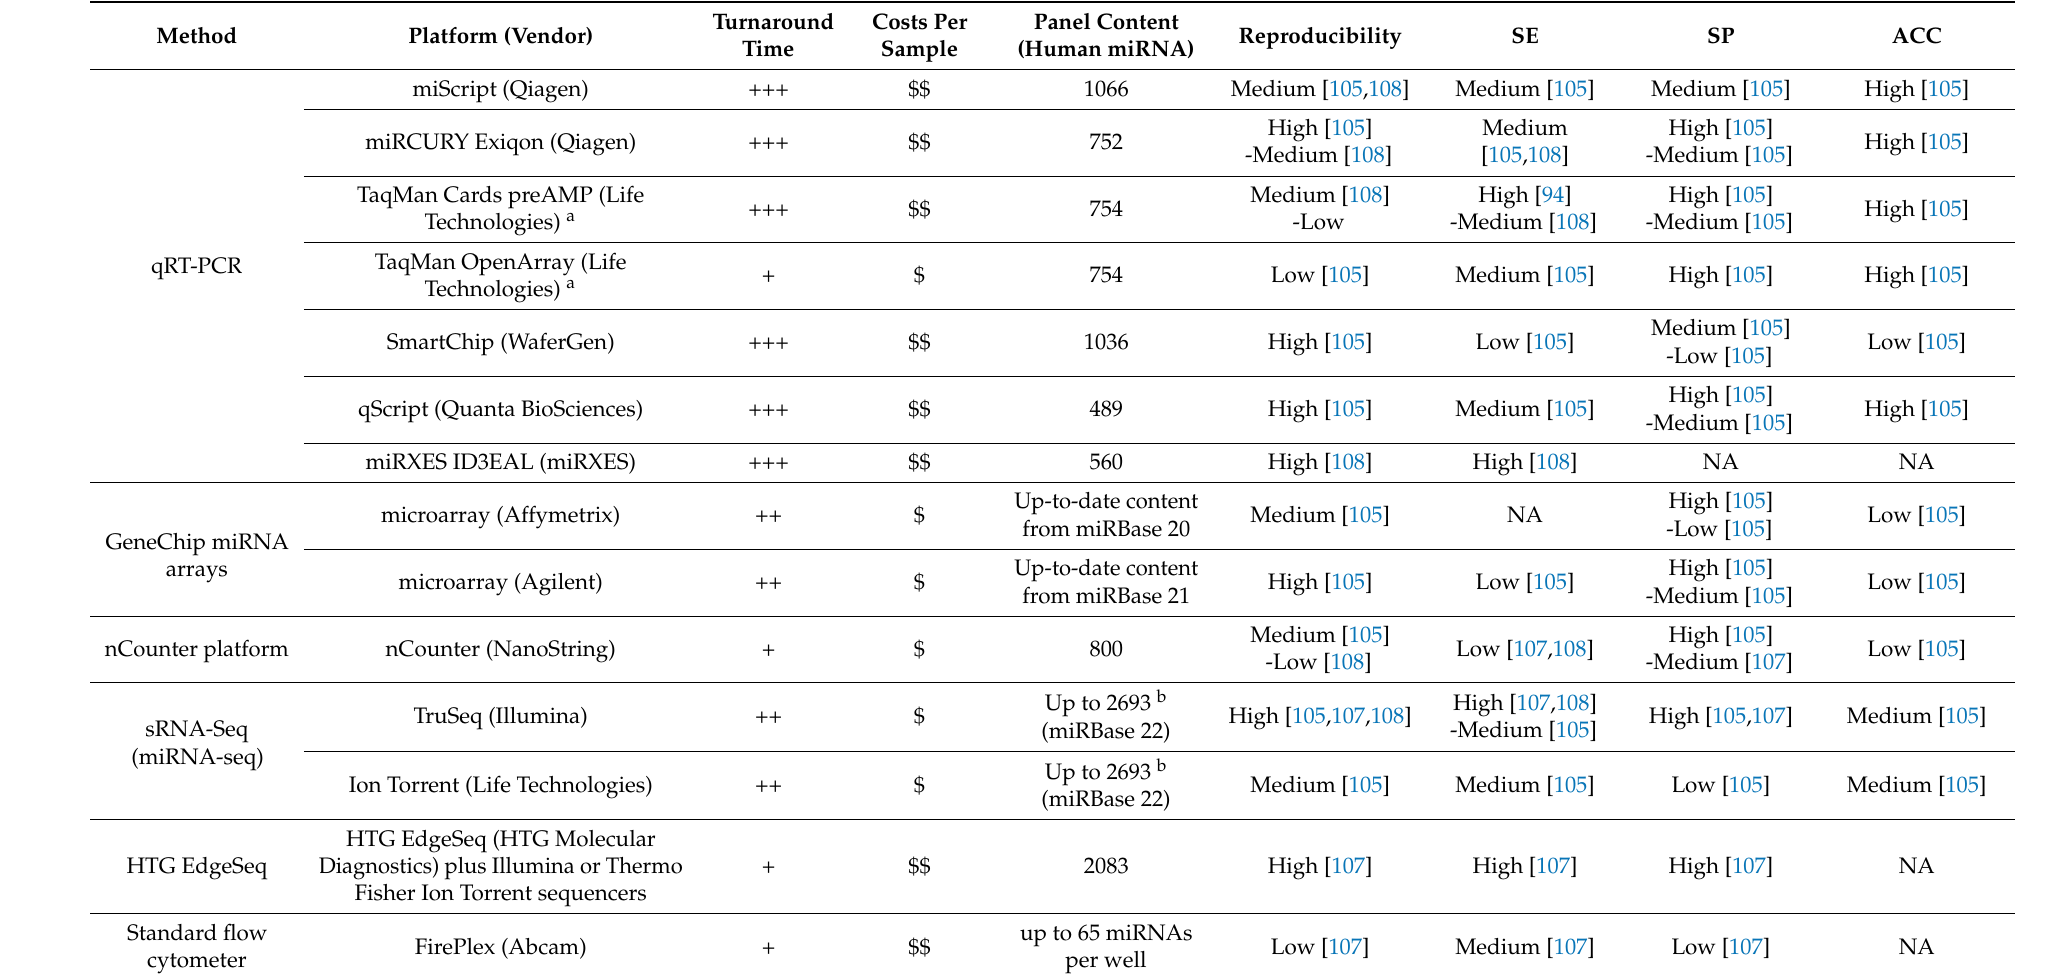
Table 3. miRNA platforms